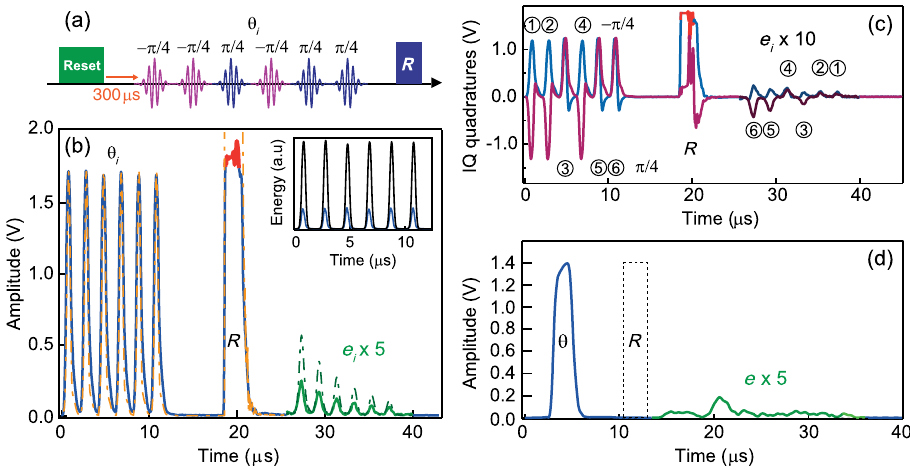
FIG. 5. Test of the 2PE protocol for multimode storage of few-photon pulses. (a) Experimental sequence including a spin reset pulse, a train of six microwave pulses θ i ( i ¼ 1 ; … ; 6 ) with an identical amplitude (corresponding to ∼ 10 4 photons in the resonator) and different phases φ 1 ¼ φ 2 ¼ φ 4 ¼ − π = 4 and φ 3 ¼ φ 5 ¼ φ 6 ¼ π = 4 , and a 50 dB stronger refocusing pulse R with phase φ ¼ 0 . 1 rad. (b) Amplitude of the measured (solid line) and calculated (dash-dotted line) output signal showing the reflected pulses r θ R (its amplitude being trimmed by amplifier saturation, shown in red), as well as the six i (after partial absorption by the spins) and reemitted echoes e i (magnified by a factor of 5). Inset: Comparison between the energies of the reflected θ i pulses with the spins saturated (black line) or reset in their ground state (blue line) shows that about 75% of the incident power is absorbed by the spins. (c) In ‐ phase (blue solid line) and Out ‐ of ‐ Phase (purple solid line) quadratures I and Q of the output signal, showing that the e i pulses (magnified by 10) are recovered with phase − ð φ i − φ r Þ , as expected. (d) Spin echo e of ∼ 0 . 02 photons in the resonator for a low- power incoming θ pulse populating the resonator with only ∼ 100 photons. The refocusing pulse (dashed line) was suppressed in the room-temperature detection chain by a microwave switch to avoid saturating the follow-up